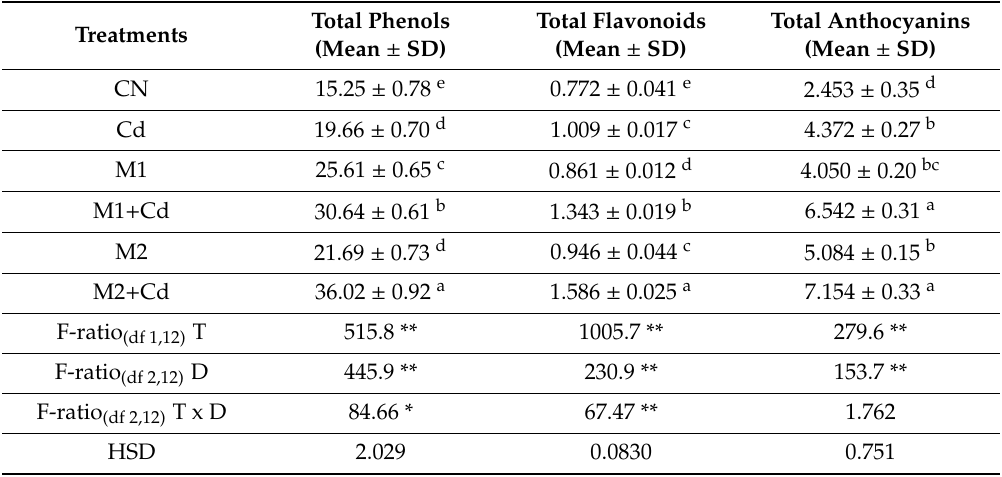
Table 2. E ff ect of Cd (0.4 mM), M1 (10 9 cells / mL), and M2 (10 9 cells / mL) and their combinations on Phenolic